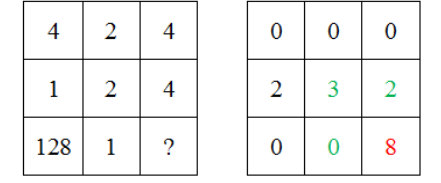
Figure 3. The calculation method of the accumulation of